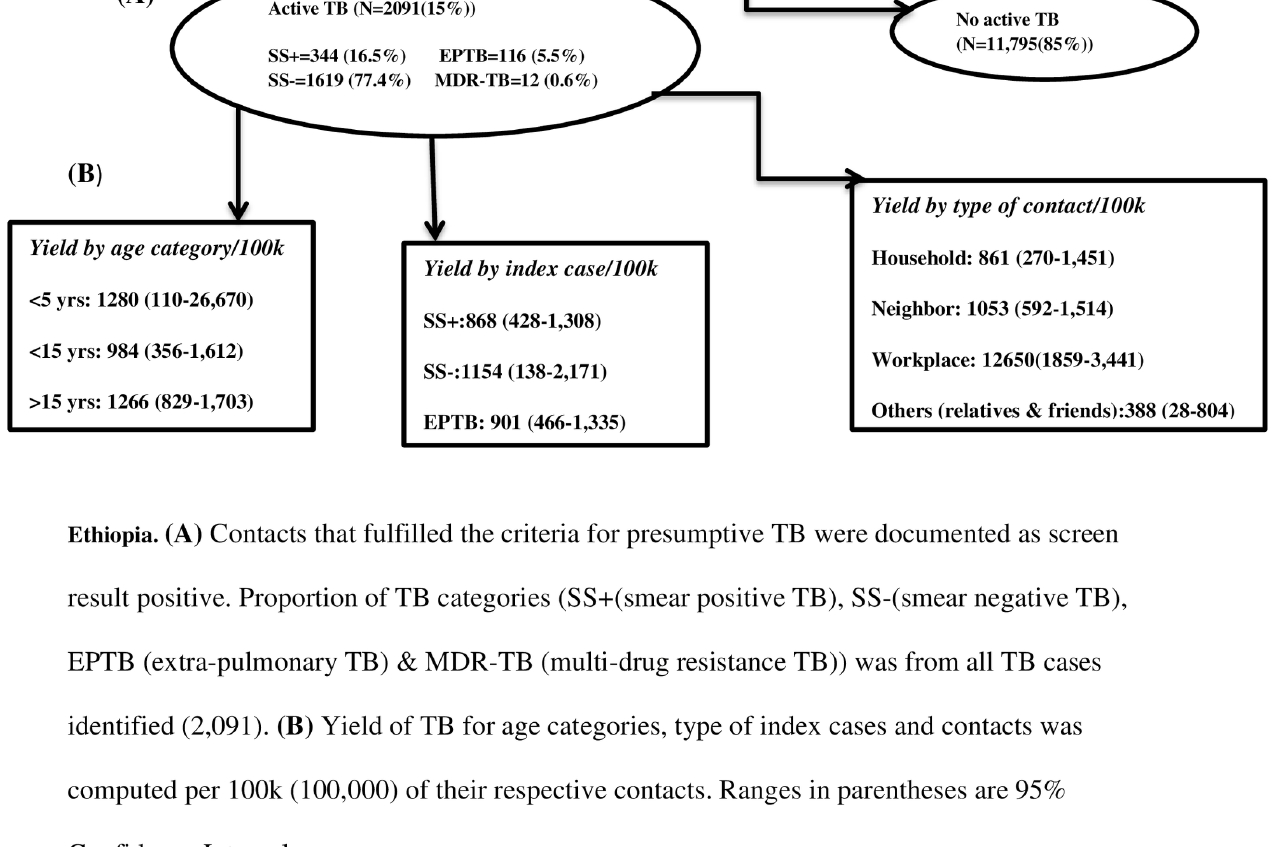
PLOS ONE | DOI:10.1371/journal.pone.0160514 August 2,